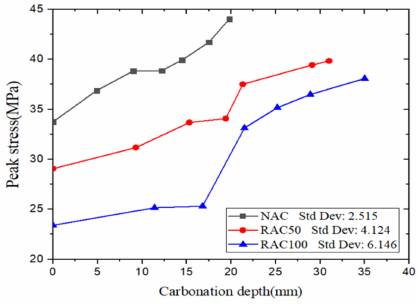
Figure 8. Peak stress versus carbonation depth.